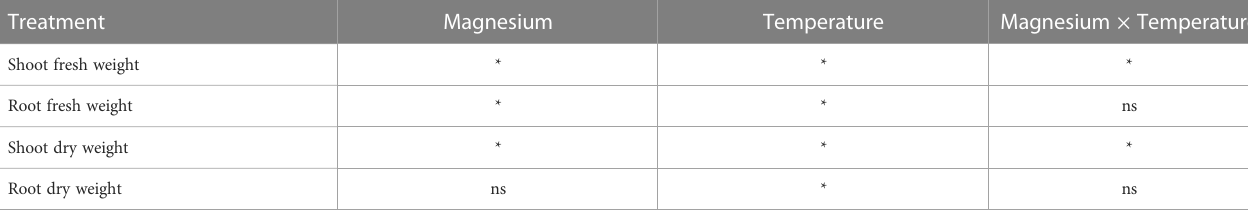
TABLE 1 Results of Two-way ANOVAs on tobacco morphological traits.